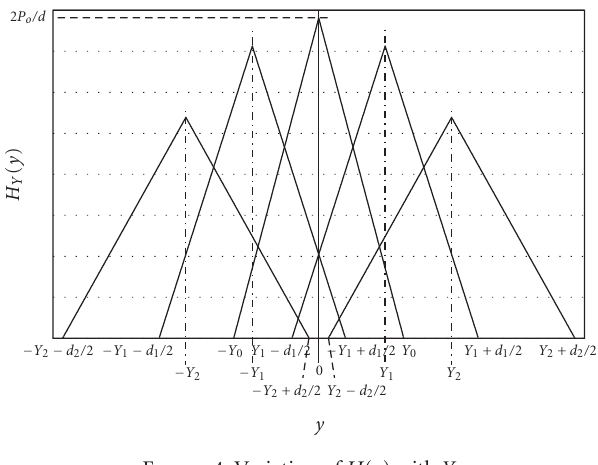
Figure 4: Variation of H ( y ) with Y .